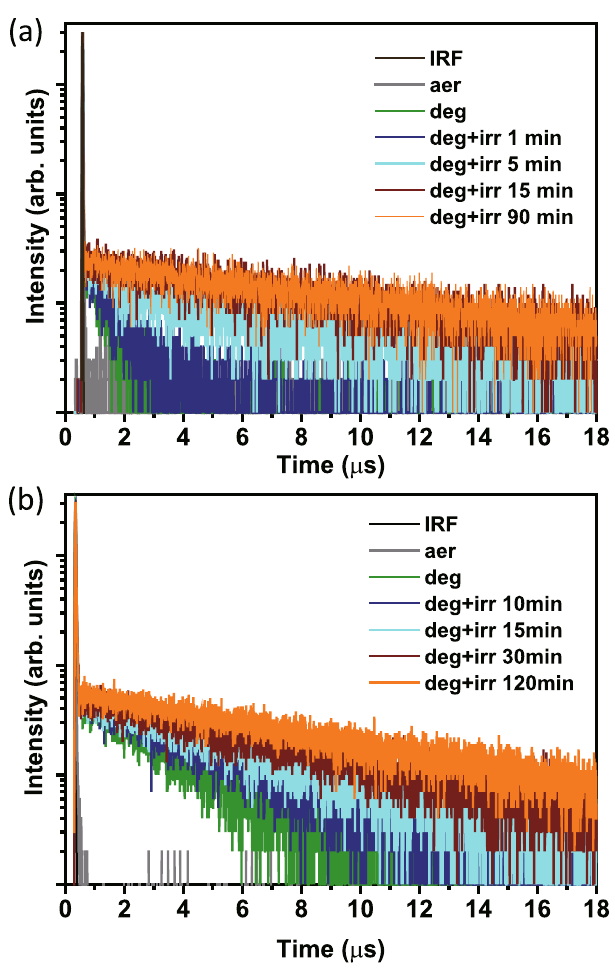
Fig. 4 Irradiation time-dependent emission kinetic pro fi les. The TADF decay dynamics of ( a ) PZDN and ( b ) PZTN as a function of irradiation (405 nm) time in room-temperature degassed cyclohexane. “ aer ” , “ deg ” and “ irr ” refer to aerated conditions, degassed conditions and light irradiation conditions,